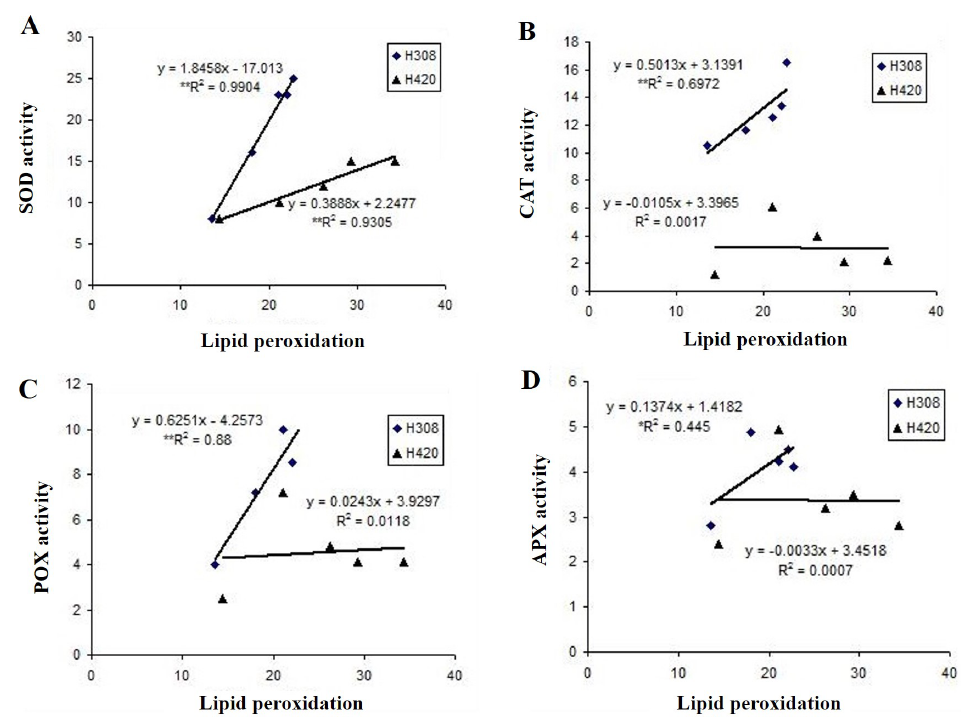
Fig. 7. The correlations between lipid peroxidation and antioxidant enzymes activity in two canola genotypes (H308, H420). **, * mean significant at P<0.01 and P<0.05, respectively.